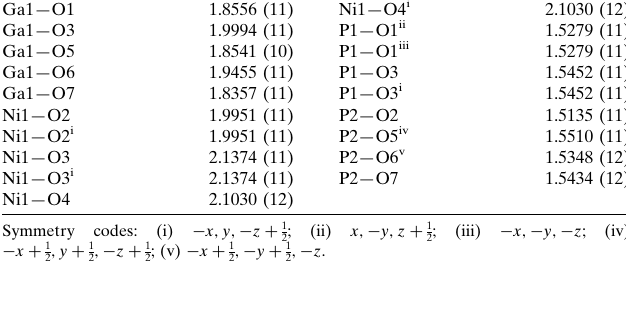
Selected geometric parameters (A˚ , (cid:2) ).